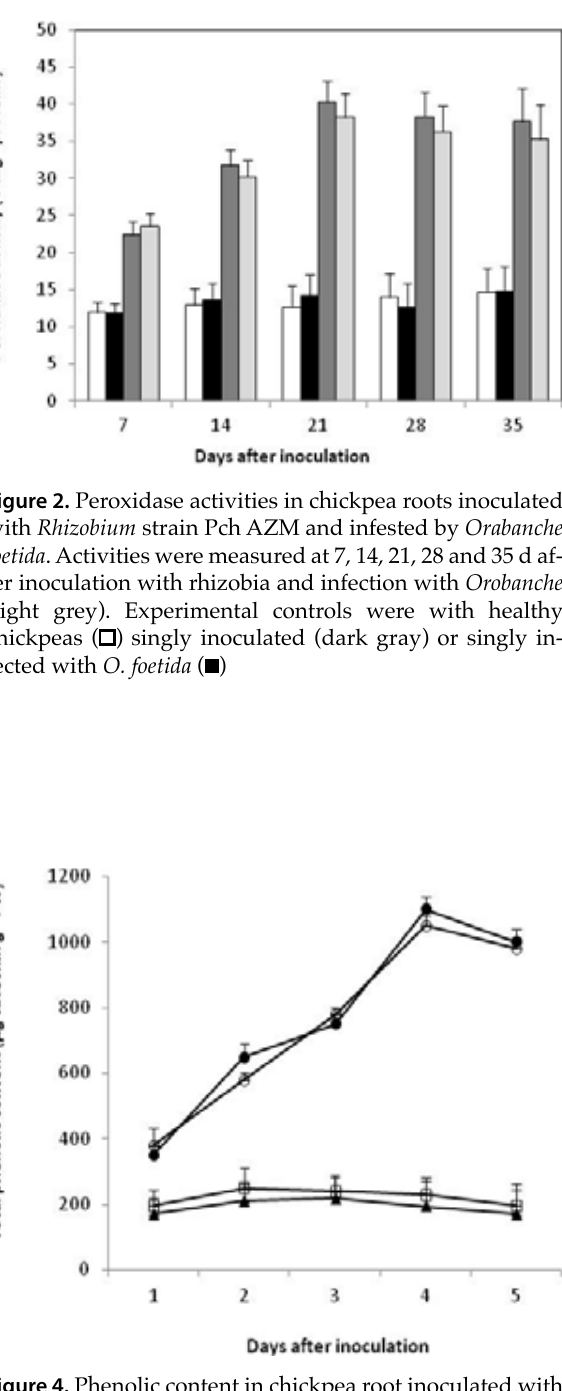
Figure 4. Phenolic content in chickpea root inoculated with Rhizobium strain PchAZM and infested by O. foetida . Con- tents were measured on 7, 14, 21, 28 and 35 days after in- oculation with rhizobia and infection with Orobanche (●). Control was performed with healthy chickpeas ( □ ) singly inoculated ( ○ ) or singly infected with O. foetida ( ▲